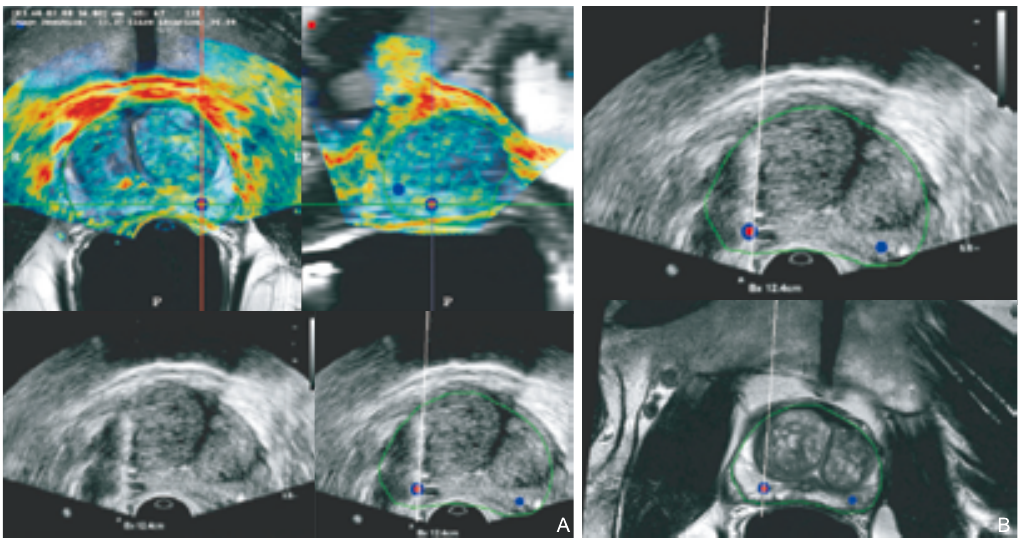
Figure 5 Screenshots of fused MRI/TRUS image guidance. (A) T2-weighted MRI fused with reference ultrasound volume (color map), along with the real-time ultrasound and target information. (B) Corresponding real-time ultrasound (top) and MRI MPR views (bottom) at the time of needle deployment. (Reprinted with permission from